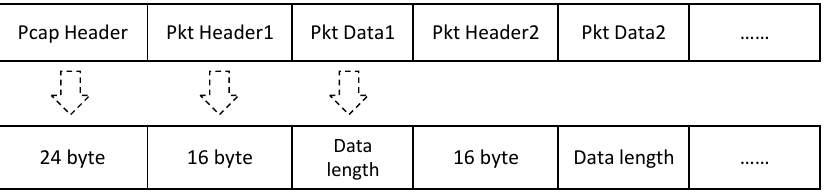
Figure 6. The structure of a PCAP file which consists of a PCAP header, a number of data packets with the packet header and packet content.